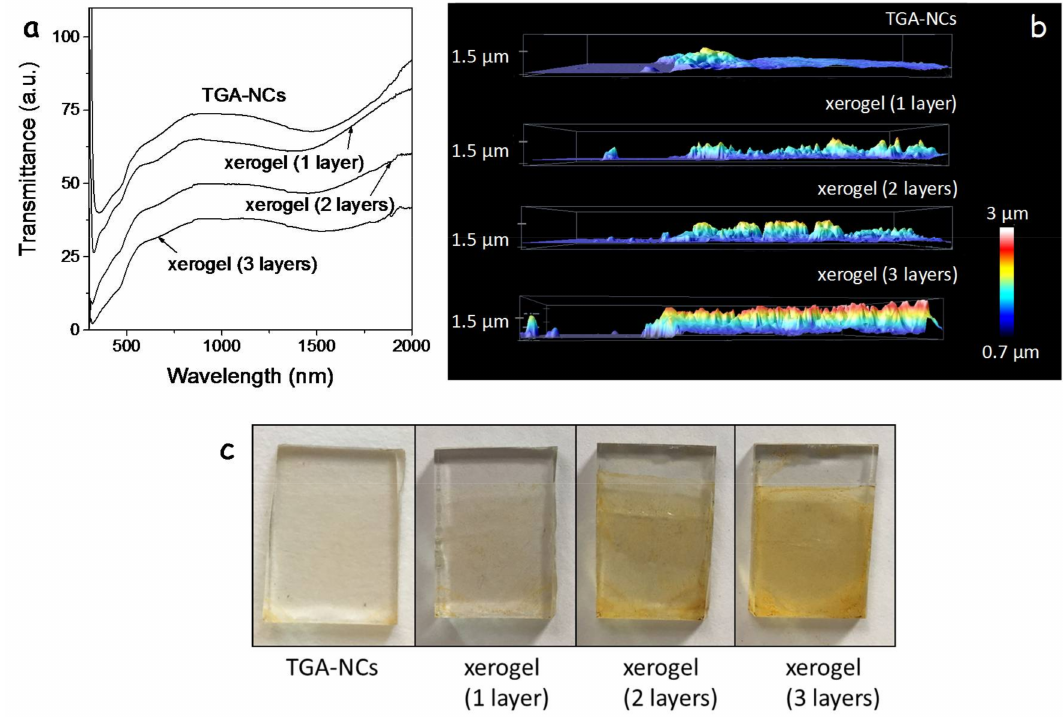
Figure 4. ( a ) transmittance spectra of films produced from as-synthesized NCs, TGA-NCs, and xerogel films with different numbers of layers (1 layer, 2 layers; 3 layers); ( b ) thickness profiles of the produced films; ( c ) optical photographs of the